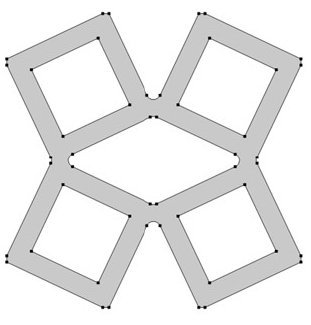
Figure 9. The obtained unit cell for fillet radius = 0.05.